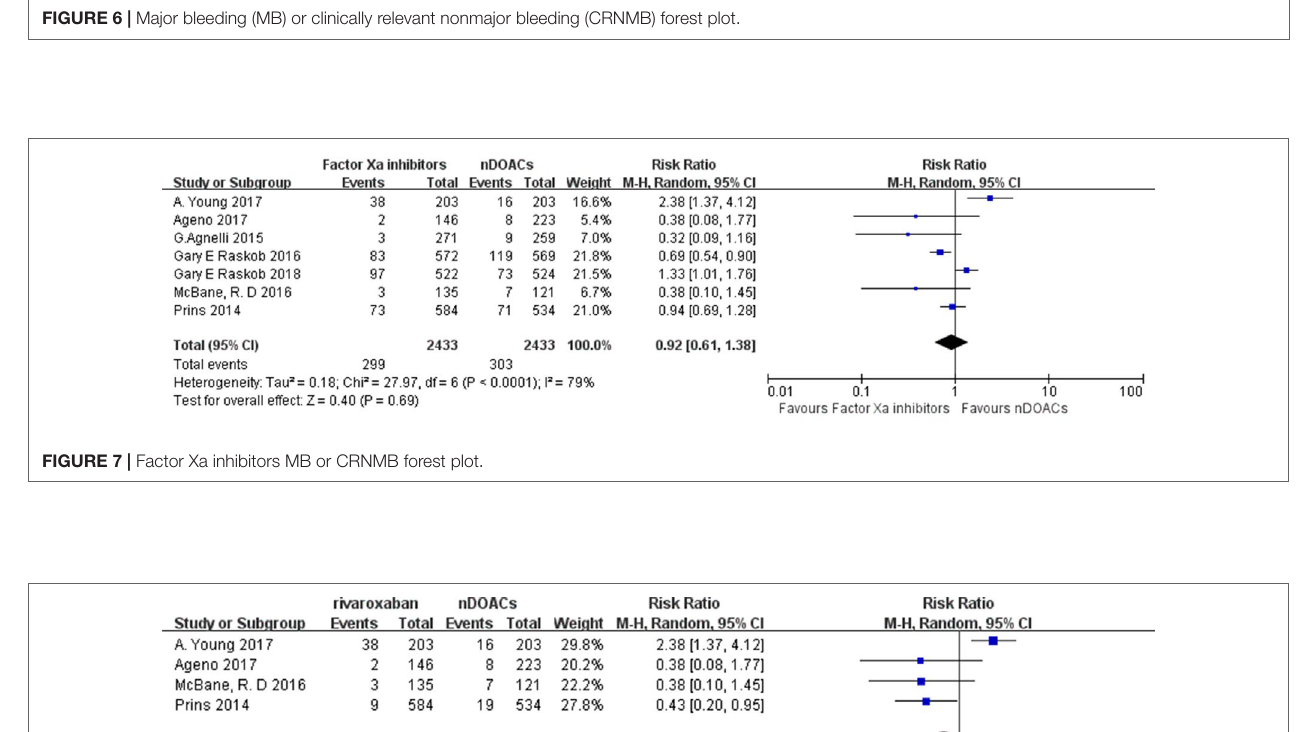
FIGURE 6 | Major bleeding (MB) or clinically relevant nonmajor bleeding (CRNMB) forest plot.